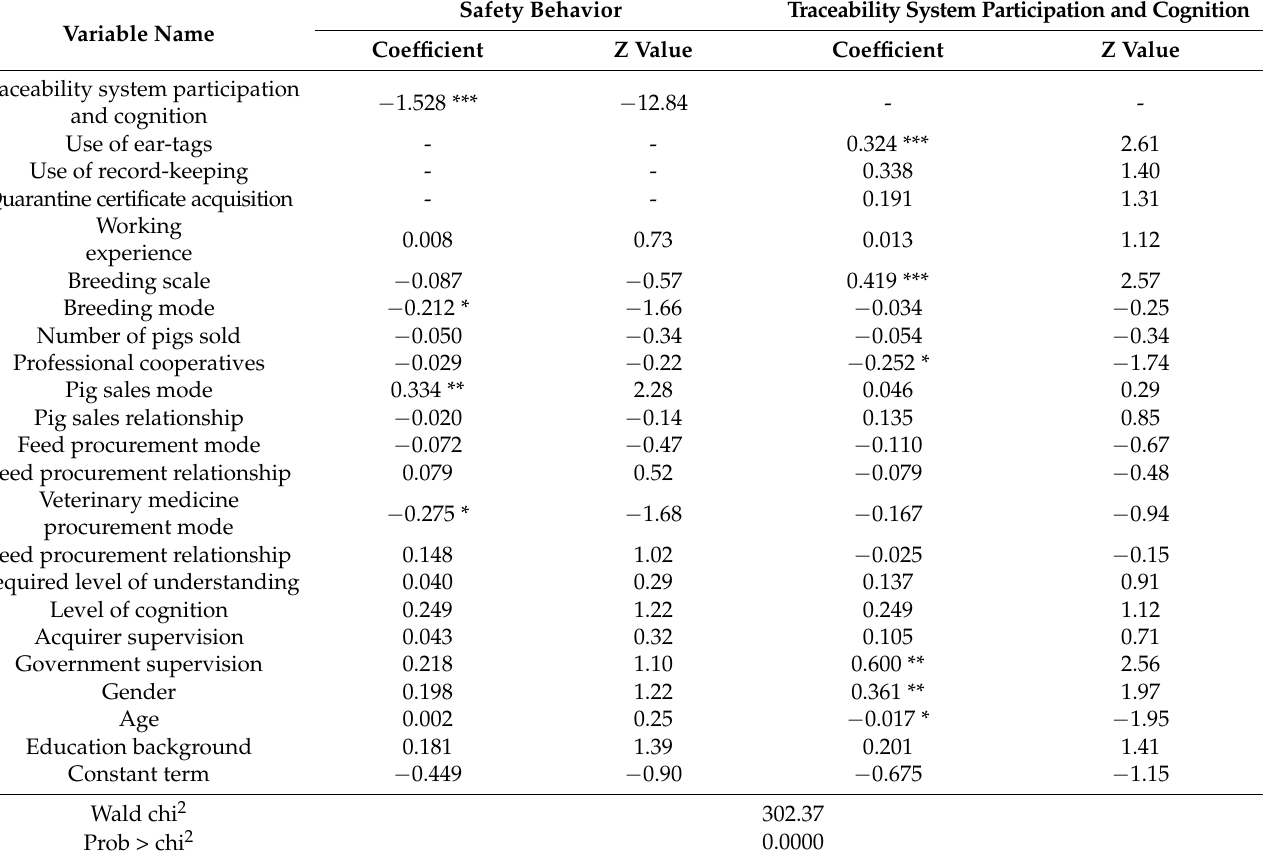
Table 4. Model estimation